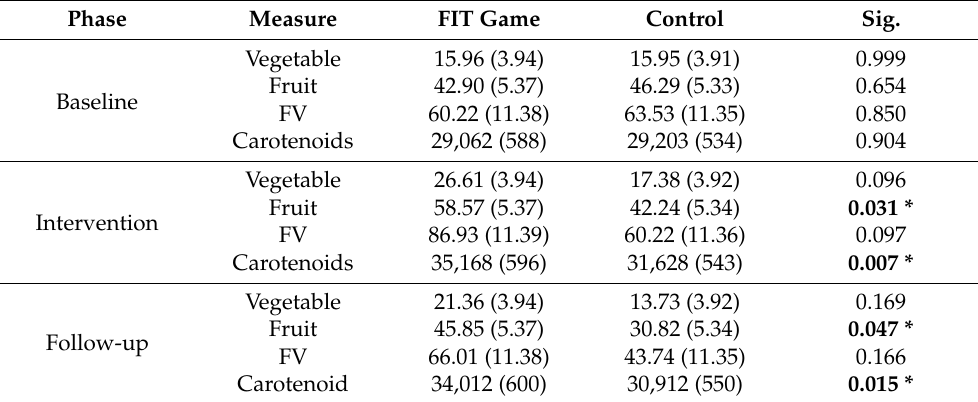
Table 3. Estimated group marginal means ( ± SEM) vegetable and fruit consumption (in grams) and skin carotenoid counts in each phase of the experiment with between-group comparisons across the phase of the